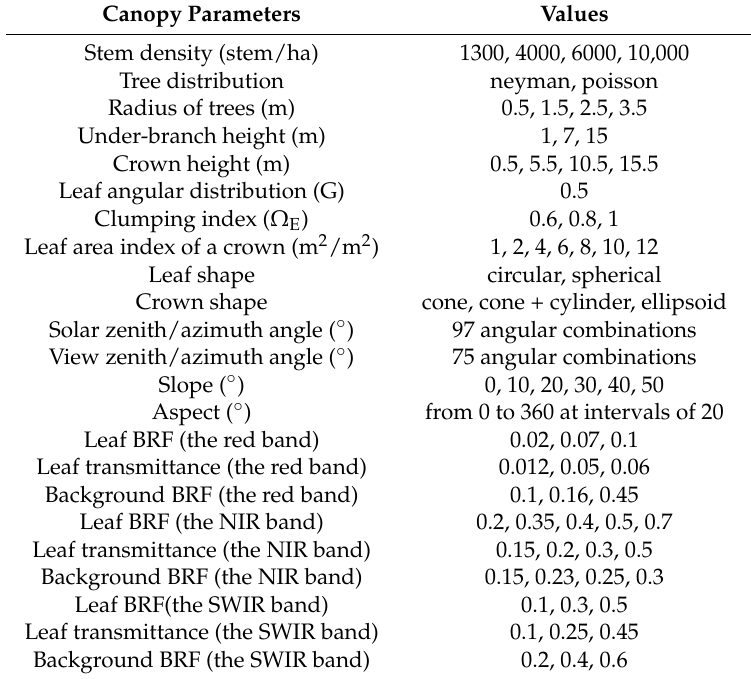
Table 2. The preset canopy parameters for constructing the look up table (LUT) using the GOST2